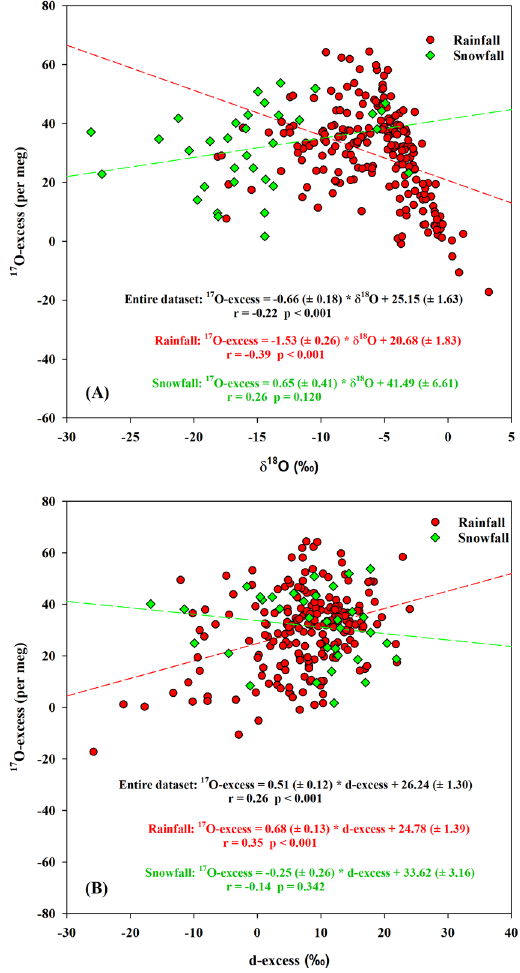
Figure 8. The relationships between 17 O-excess and both δ 18 O ( A ) and d-excess ( B ) for rainfall and snowfall between June 2014 and May